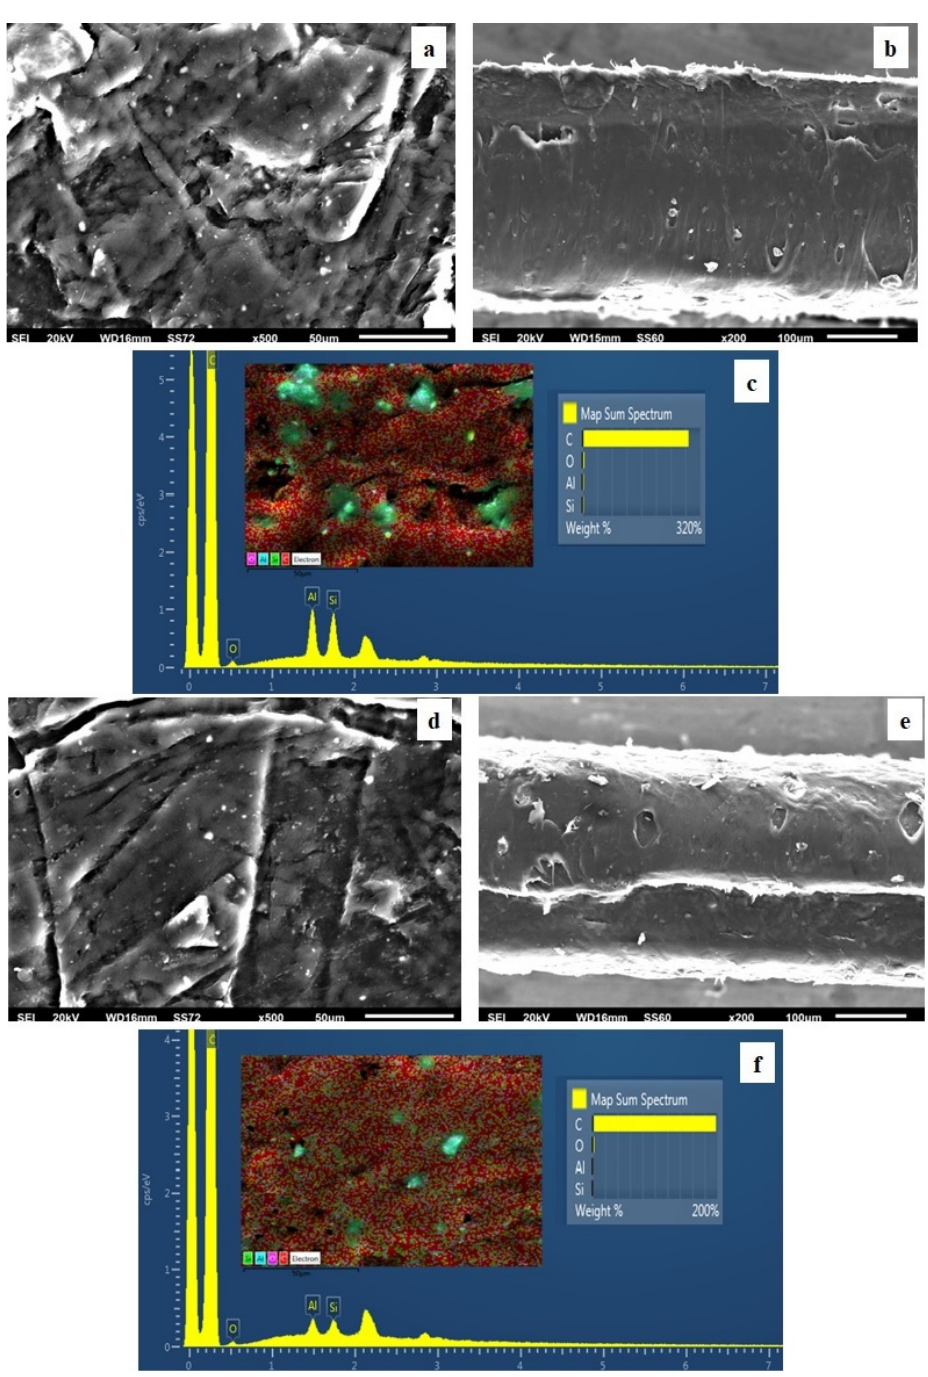
Figure 5. ( a , d ) SEM images of surface and ( b , e ) cross-section for the nanocomposite films of LDPE/5HNT ( a , b ) and LDPE/5TO@HNT ( d , e ), respectively. ( c , f ) Energy dispersive spectrometer (EDS) spectra, relative elemental analysis, and mapping of the surface from the SEM images at x1000 magnification.